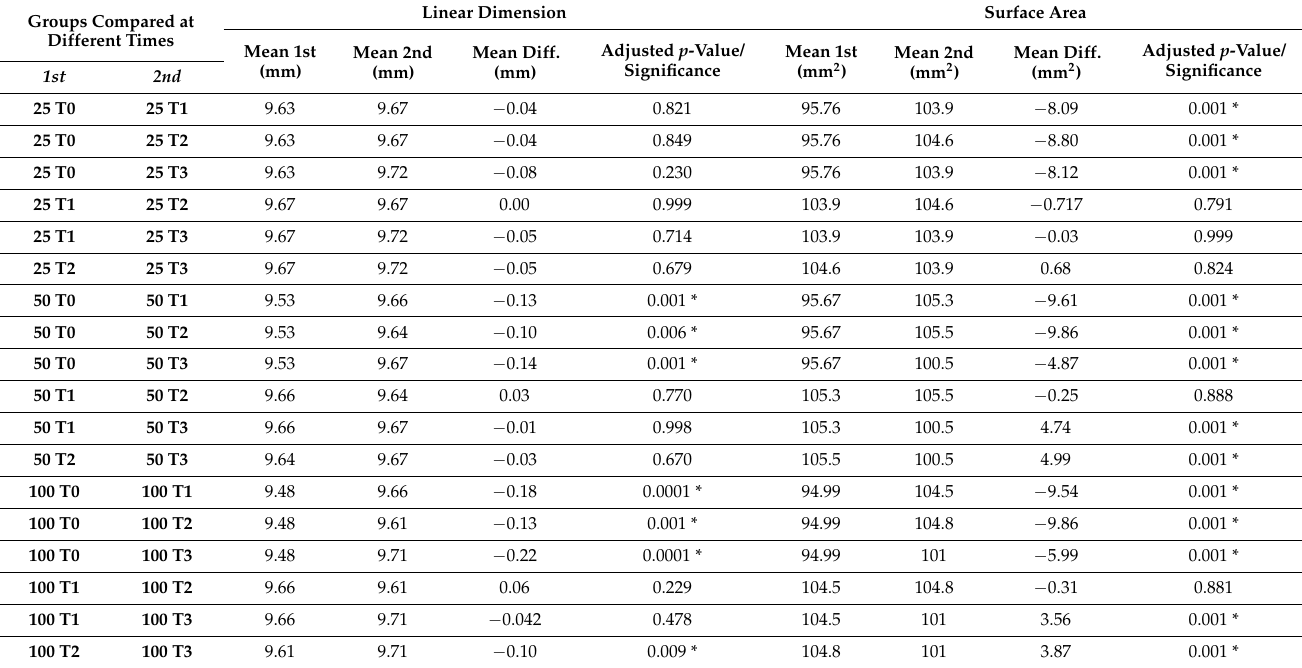
Table 3. The dimensional stability of linear and surface area over time in the 25 µ m, 50 µ m, and 100 µ m groups, using one-way ANOVA and Tukey’s post hoc. * p < 0.05. Groups Compared at Different